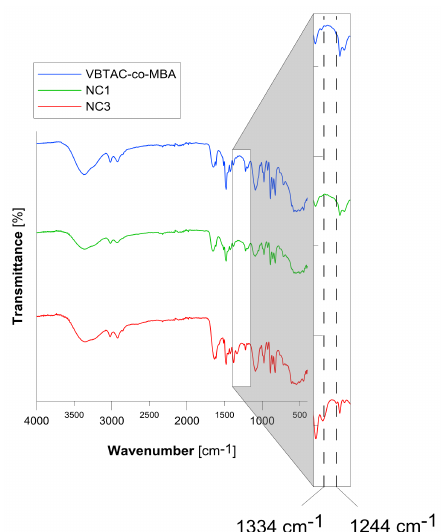
Figure 3. Fourier Transform Infrared Spectroscopy (FT-IR) spectra recorded for raw the VBTAC- co -MBA copolymer and the Au/VBTAC- co -MBA nanocomposites NC1 and